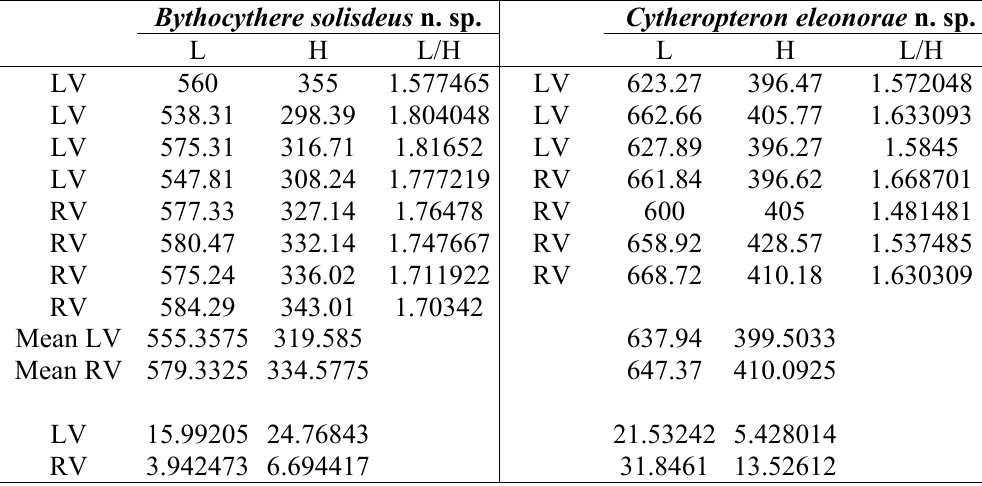
Table 2. Size of B. solisdeus and C. eleonorae . Bythocythere solisdeus n. sp. Cytheropteron eleonorae n.